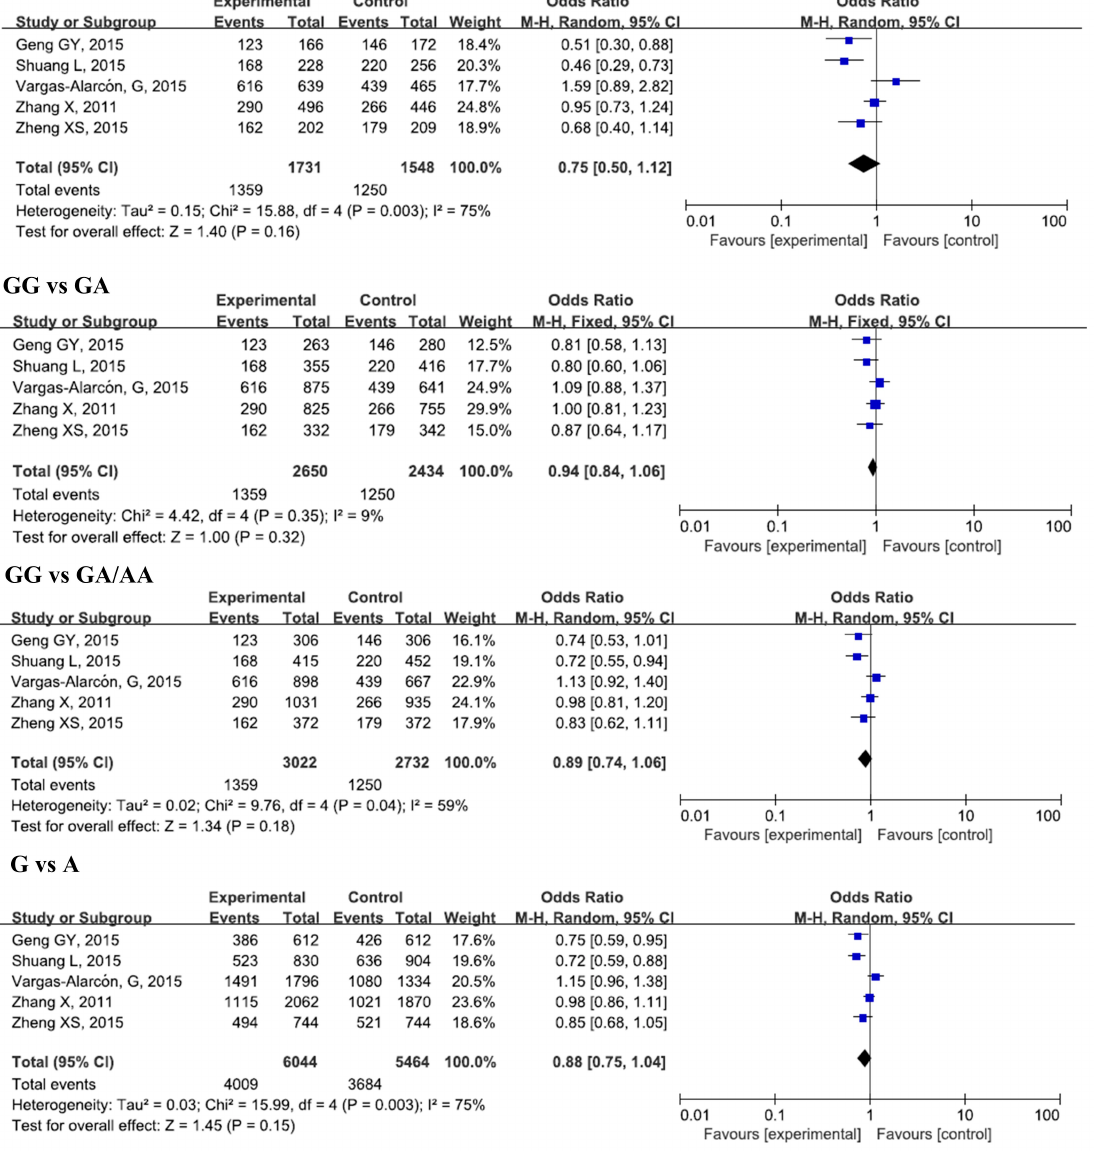
Figure 2. Forest plots of odds ratios for the association of IL-17A rs2275913 with risk of CAD.